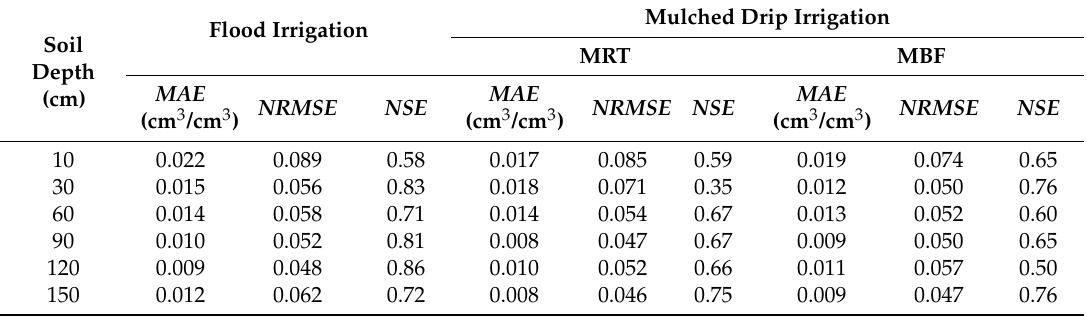
Figure 4. Simulated and measured soil water content at different soil depths under the two irrigation methods. ( a – c ): Soil water content under flood irrigation at 10, 30, 60, 90, 120, 150 cm, respectively; ( d – f ): Soil water content of MRT under mulched drip irrigation at 10, 30, 60, 90, 120, 150 cm, respectively; ( g – i ): Soil water content of MBF under mulched drip irrigation at 10, 30, 60, 90, 120, 150 cm, respectively. Table 4. MAE , NRMSE , and NSE between the simulated and measured soil water content at different soil depths.